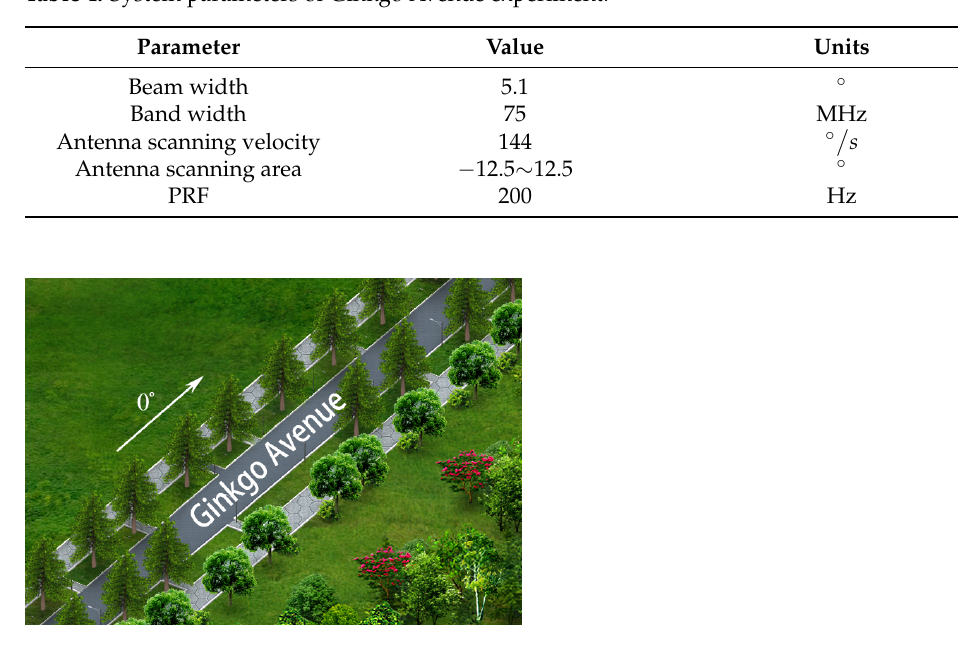
Table 4. System parameters of Ginkgo Avenue experiment.